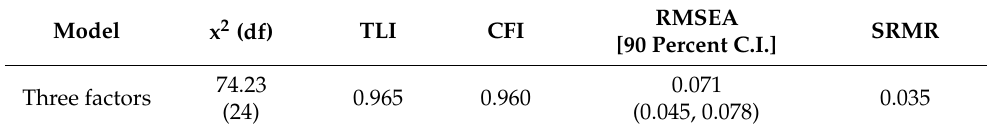
Table 4. Model-fit statistics of CFA.